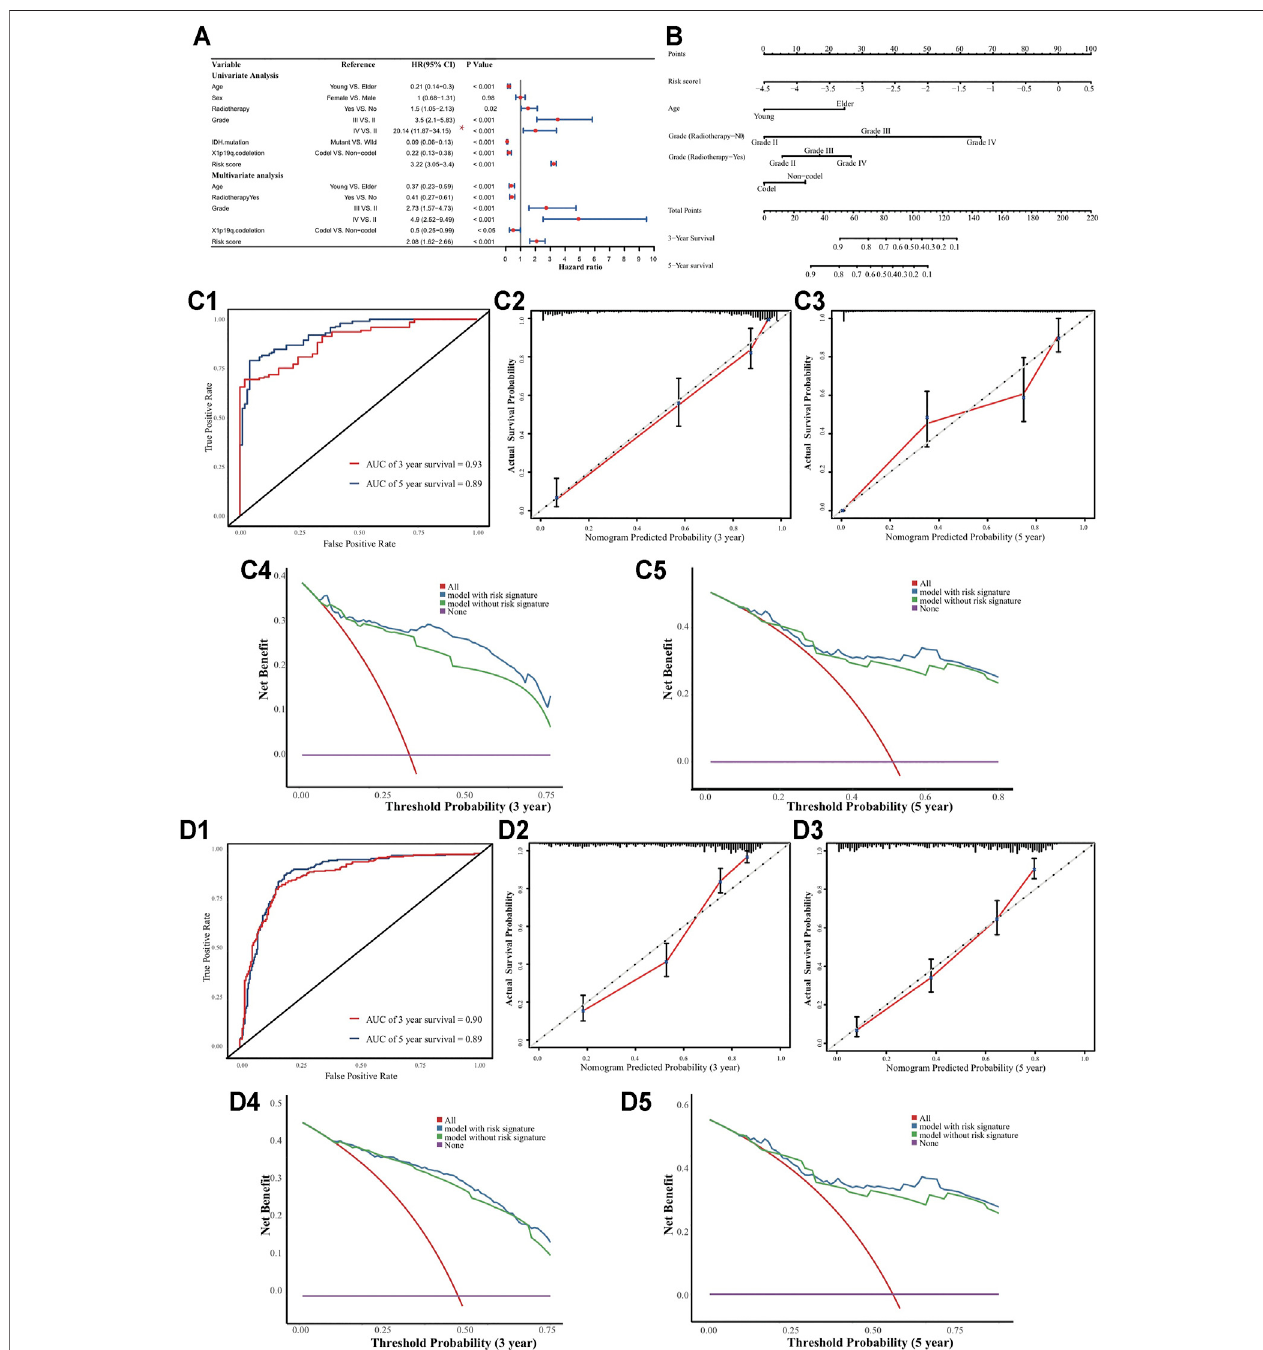
FIGURE 6 | Nomogram to predict 3 and 5 years OS. (A) Univariate and multivariate analyses. The grade III HR and its CI were divided by 10 in the forest plot. (B) Nomogram to predict the 3-, 5- and 10-years OS for LGGs patients. (C1) Time-dependent ROC curves; (C2-C3) Calibration curves; (C4-C5) DCA curves in TCGA cohort. (D1) Time-dependent ROC curves; (D2-D3) Calibration curves; (D4-D5) DCA curves in CGGA cohort.